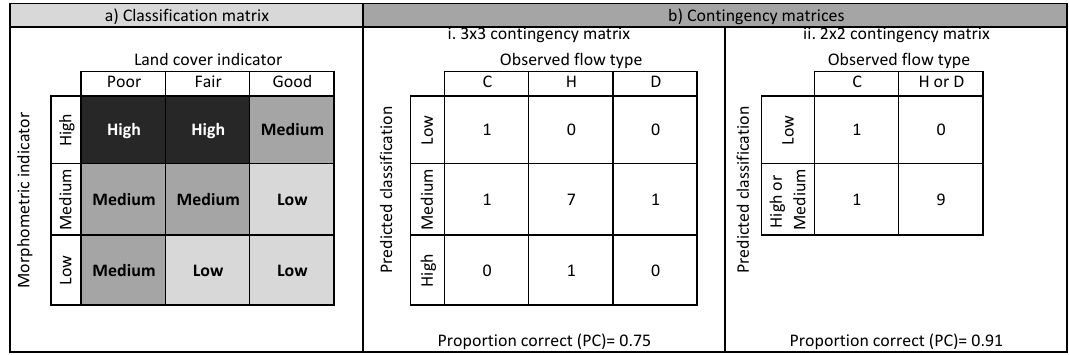
Figure 11. (a) Optimum classification matrix, (b) contingency table to compare the watershed classification according to the composite indicator (morphometric indicator and land cover indicator) and the observed flow